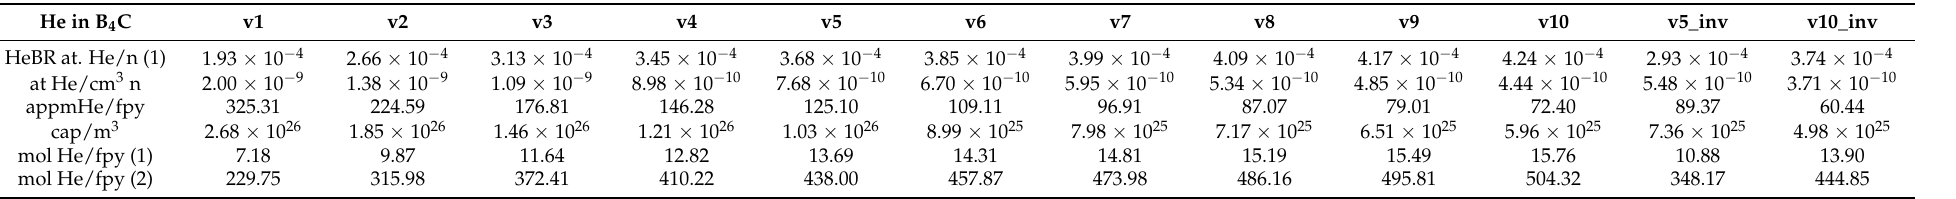
Table 6. Helium production in different magnitudes at B 4 C shield for the baseline model, versions v1–v10, and v5_inverted and v10_inverted configurations.